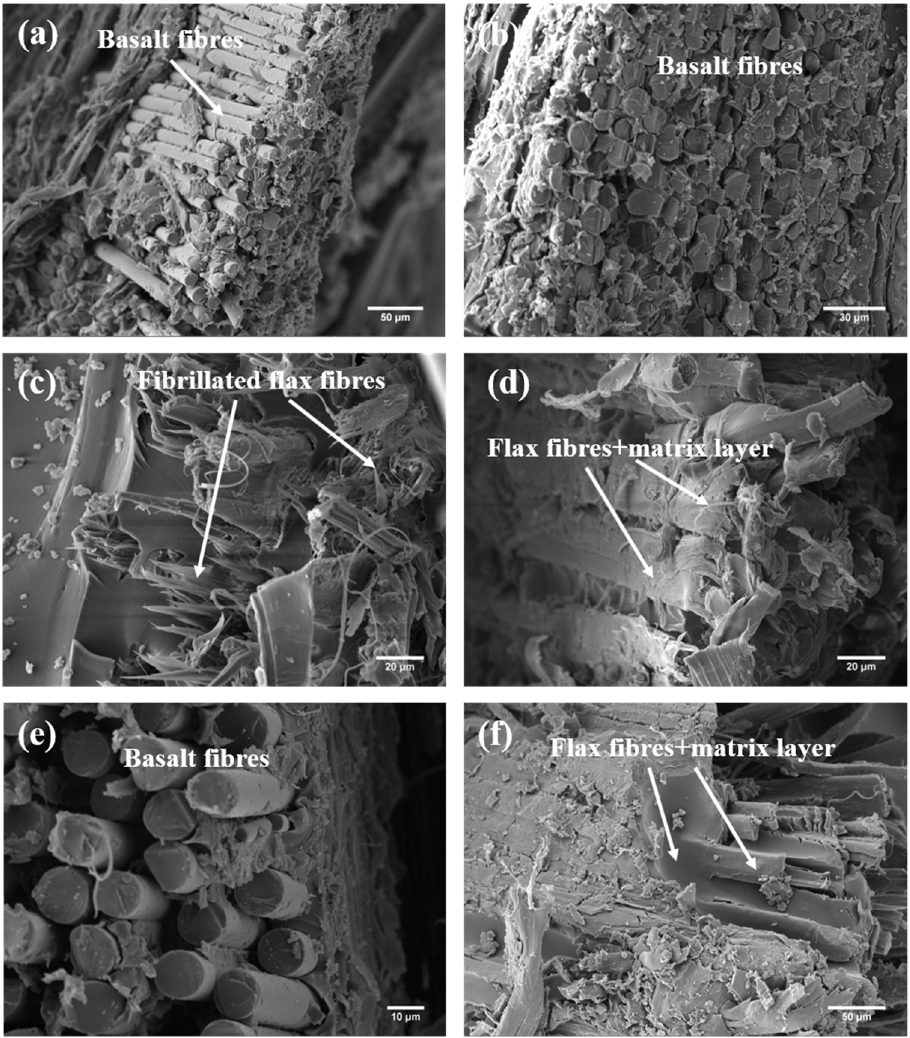
Figure 6. SEM micrographs of failed flexural H_Ep specimens at different magnifications, the presence of matrix layers on basalt ( a , b , e ) and flax fibers ( d , f ) and flax fiber fibrillation ( c